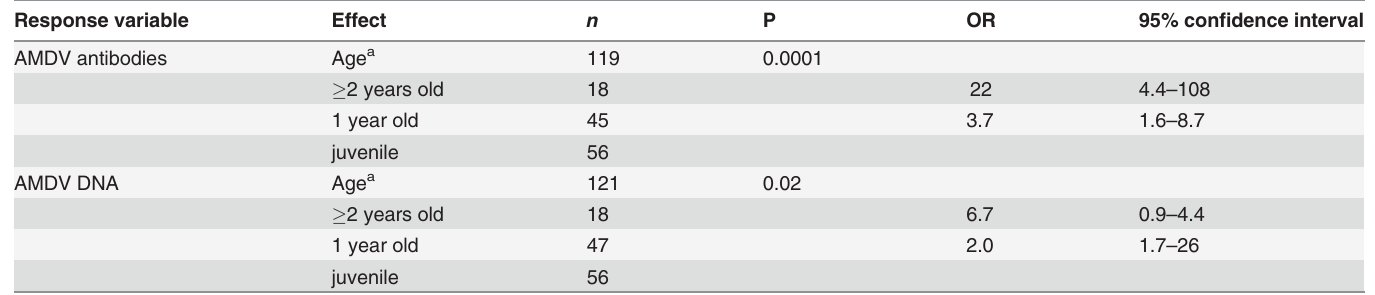
Table 2. Odds ratio estimates and effect of age class from the logistic regression model. Response